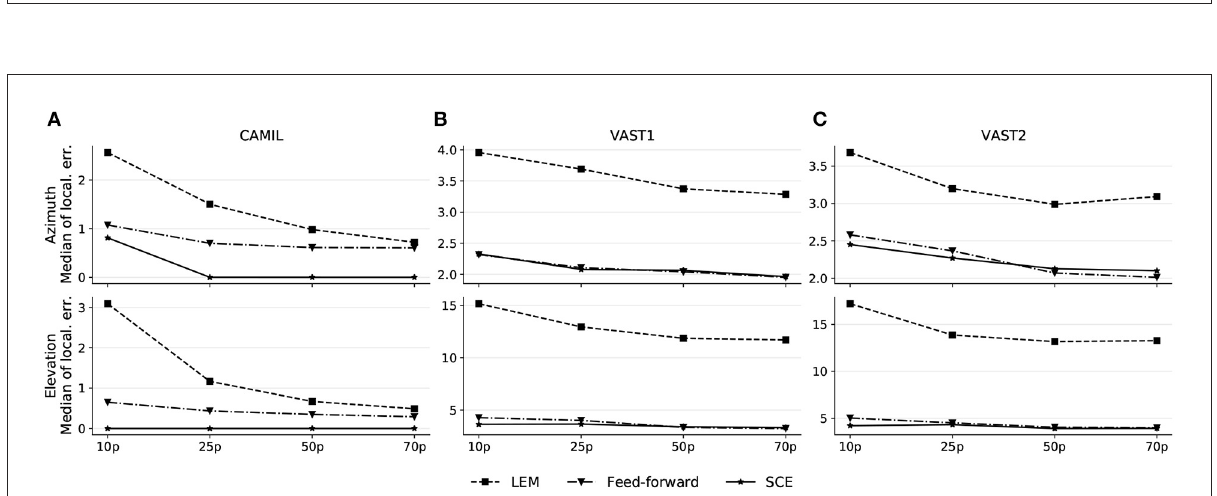
FIGURE4 Localization performance on the CAMIL testing set (A) , the VAST testing-set-1 (B) , and the VAST testing-set-2 (C) . 10p, 25p, 50p, and 70p denote the cases when 10, 25, 50, and 70% of the original training data is used, respectively.